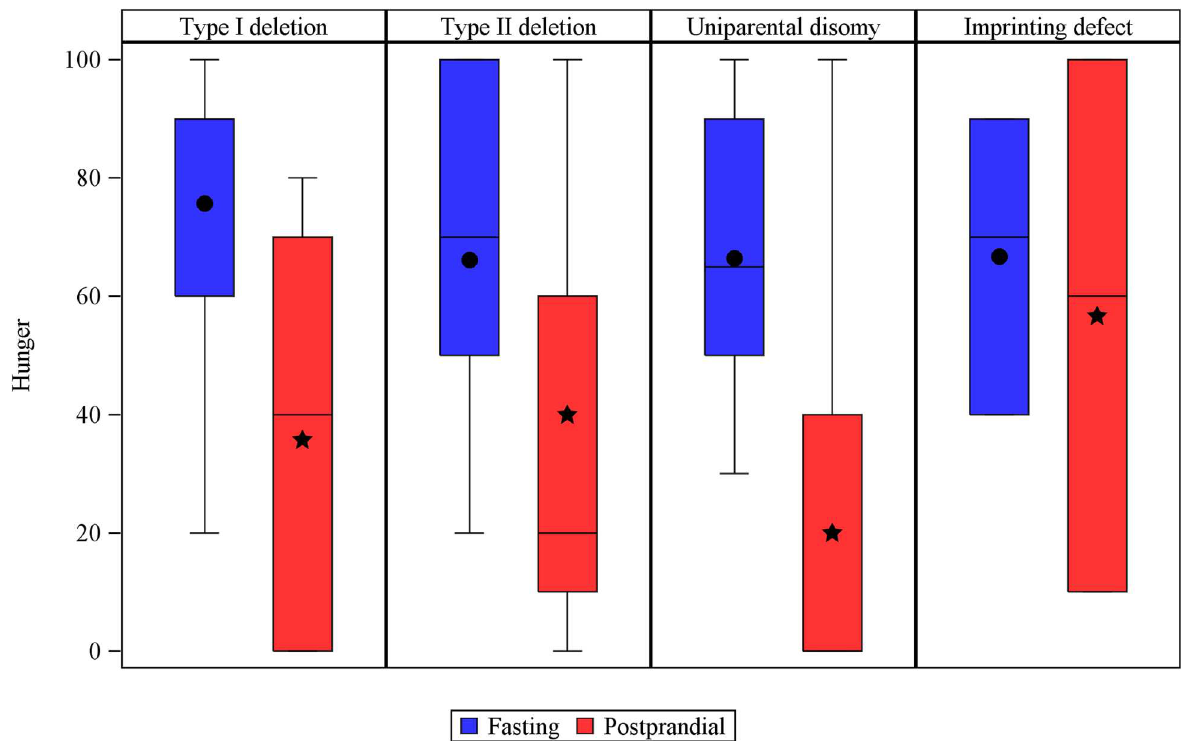
Fig 6. Hunger score at fasting (circles) versus 60’ after the meal (stars) in the different genetic subtypes of Prader-Willi syndrome subjects. P = 0.034 for uniparental disomy, nonsignificant for the rest. Hunger was quantifiedon a visual analoguescale from 0 to